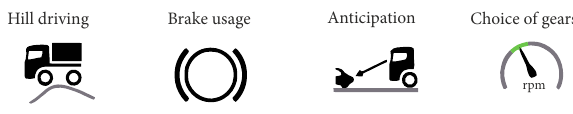
Figure 2. Scania FMS architecture